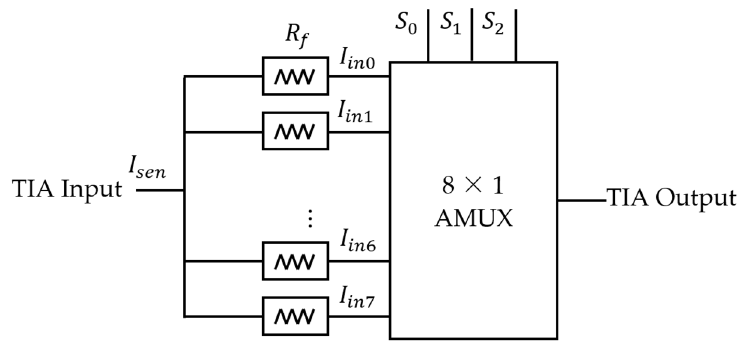
Figure 4. Op–amp gain and phase plot. Figure 4. Op − amp gain and phase plot.